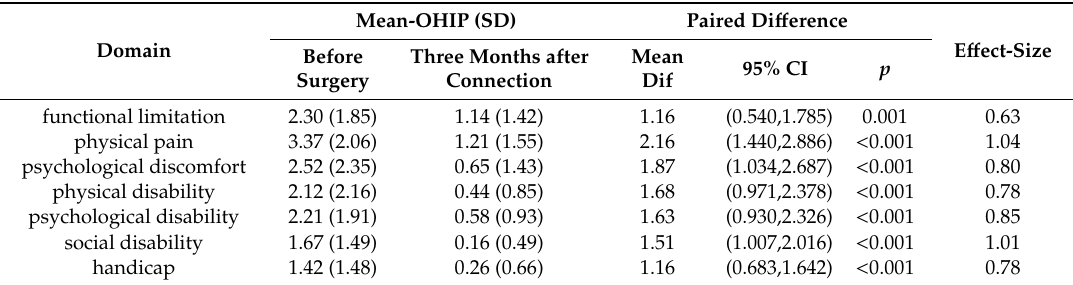
Table 5. Mean OHIP score and the mean di ff erence for each of the seven domains before surgery and three months after connection with the calculated e ff